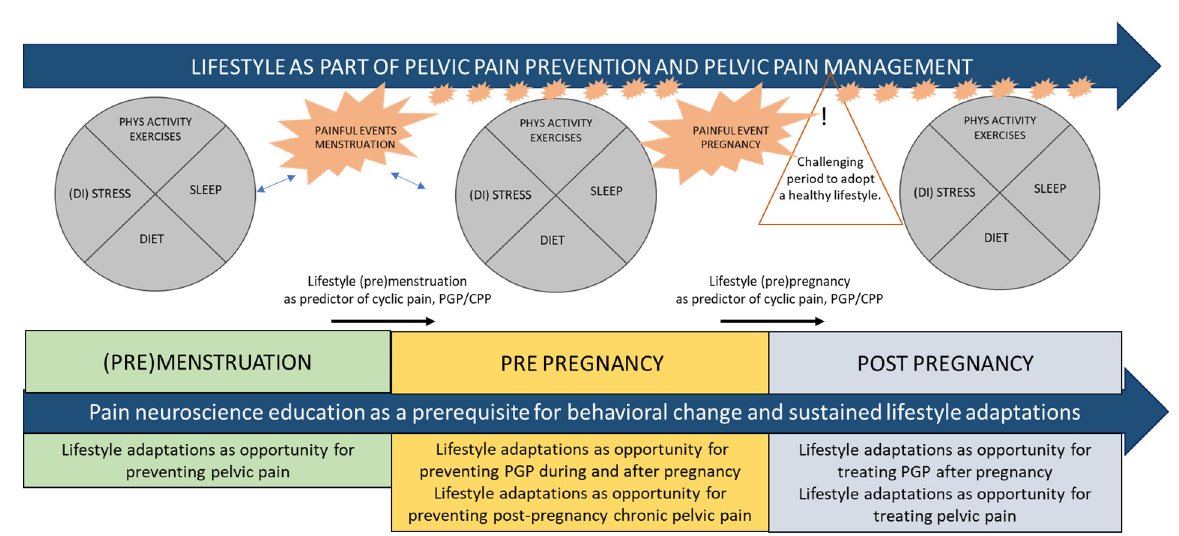
Figure 1. Women are exposed to pain in the pelvis during their lifespan in relation to hormonal changes and pregnancy. Lifestyle can influence the pain experience during the lifespan.